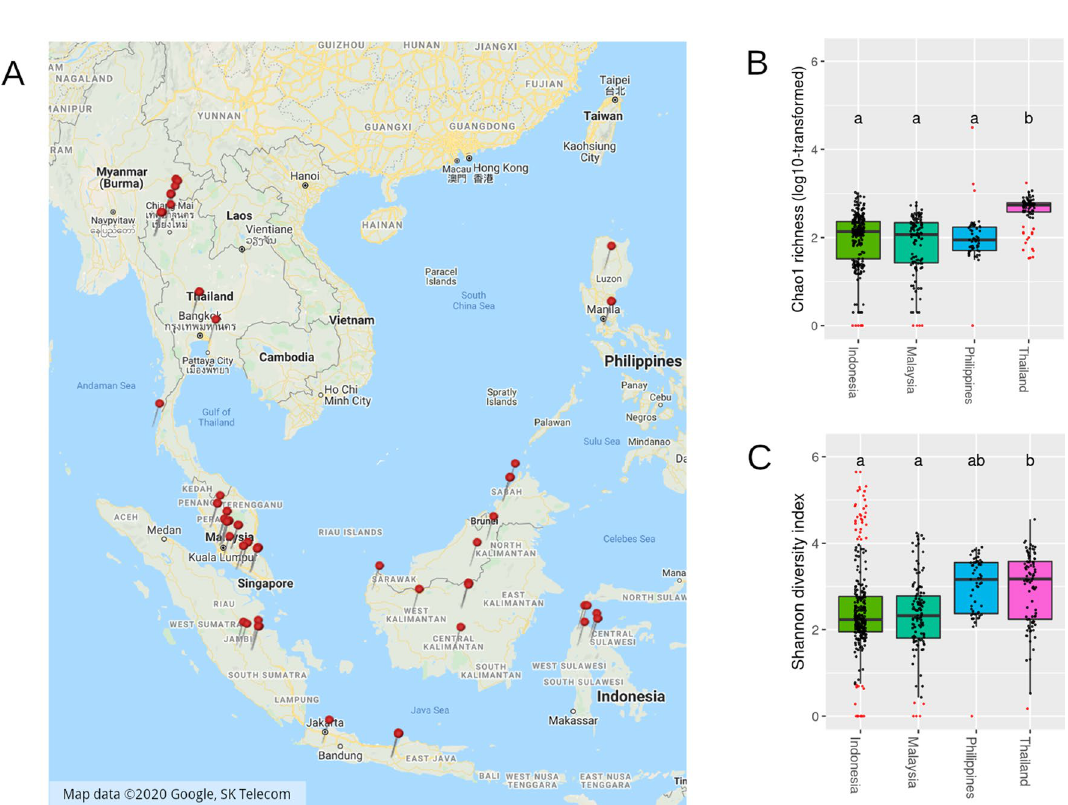
Figure 3. The soil bacterial diversity in relation to geographic locality. The geographic distribution of soil microbiome samples included in this study was shown (A). The map and sample coordinates were plotted using Google Maps data and API retrieved 7 May 2020, from https ://www.googl e.com/maps/@8.27636 09,98.12378 1,4z. The alpha diversity of biosamples was estimated by Chao1 species richness estimator (B) and Shannon’s diversity index (C). The letters over each box plot showed the significant difference groups tested by ANOVA with Tukey HSD post-hoc comparison ( P- value <